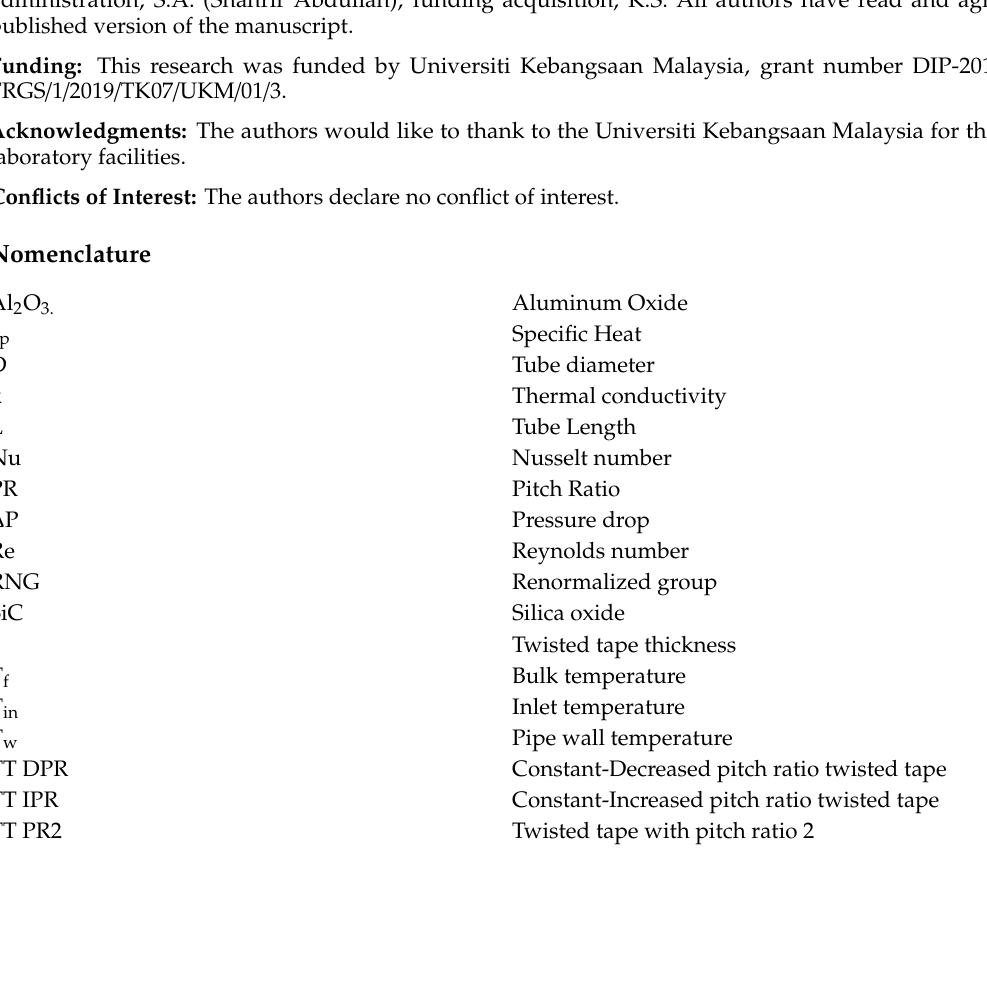
Table S1: Experimental data of Nu , Table S2: Experimental data of ∆ P , Table S3: Experimental data of f , Table S4: Experimental data of Nu / Nu p , Table S5: Experimental data of f / f p , Table S6: Experimental data of η . Author Contributions: Conceptualization, S.A. (Saadah Ahmad) and K.S.; methodology, S.A. (Saadah